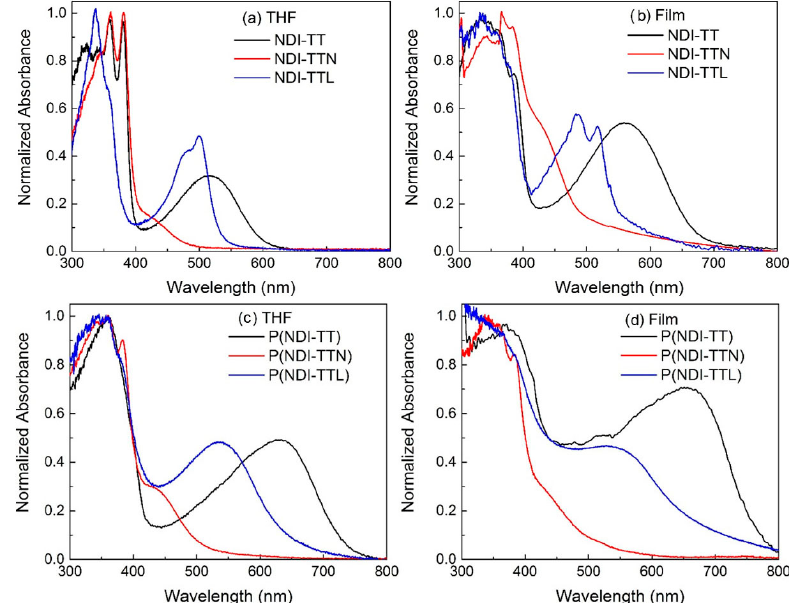
Figure 6. ( a , c ) Solution UV-vis absorption spectra; ( b , d ) thin-film UV-vis absorption